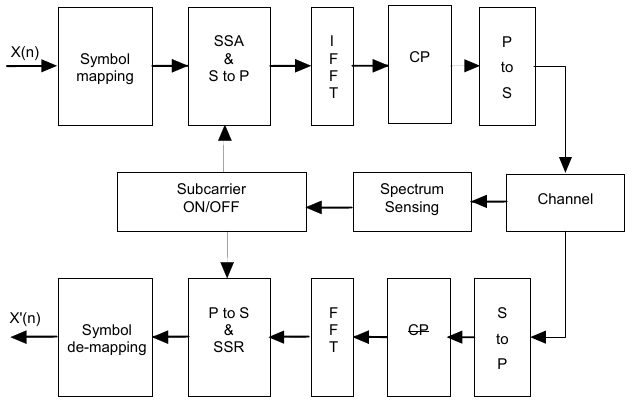
Figure 2. Schematic of an NC-OFDM transceiver.